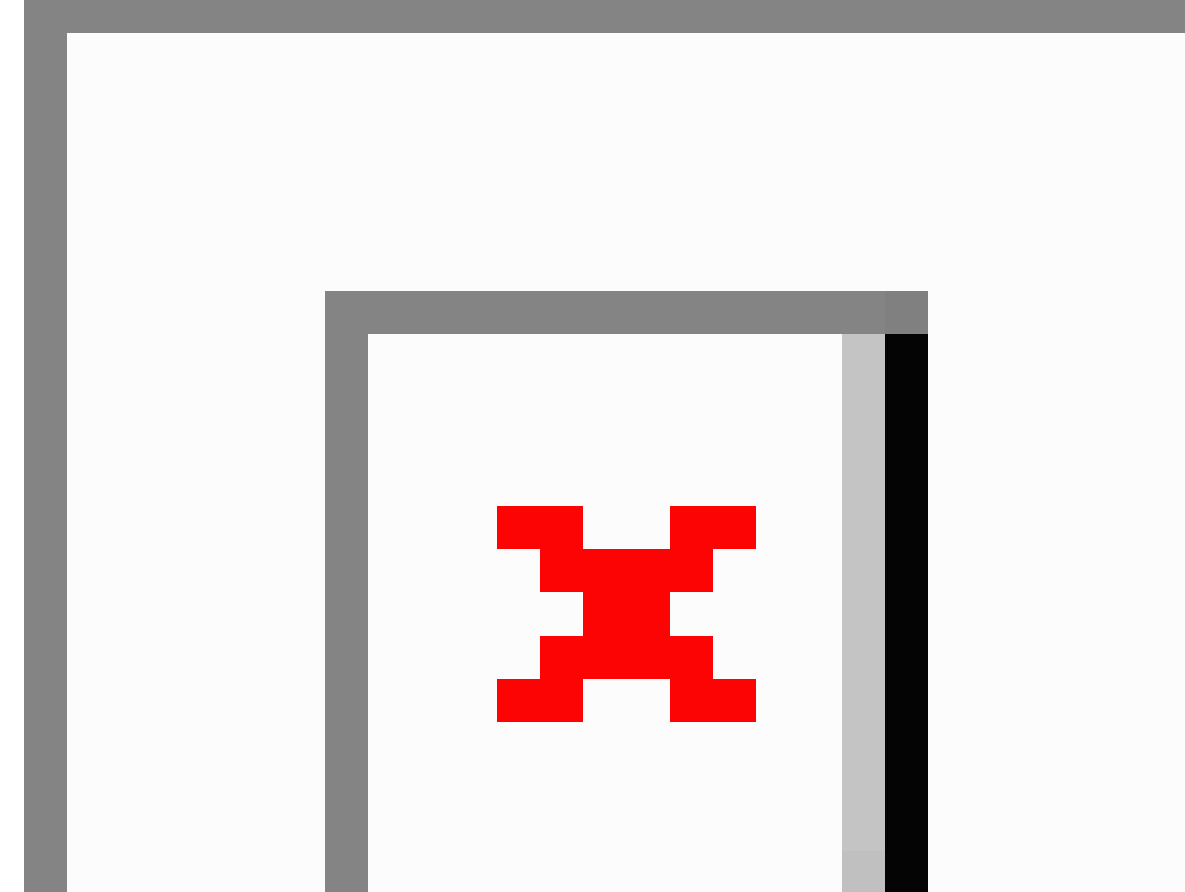
Figure 1. Flow of information through the different phases of the systematic review. Asterisk indicates that this search was limited to systematic